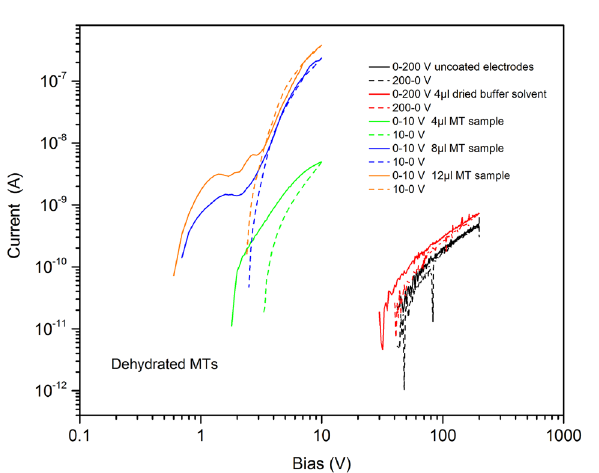
Figure 3. Current oscillations from a flat sheet of MTs in the presence of KCl 140 mM in the pipette and buffer A in the bath. Measurements at several holding potentials as indicated (left). Regions 1 and 2 are expanded on the right to reveal the presence of electrical oscillations. Data representative of four experiments.